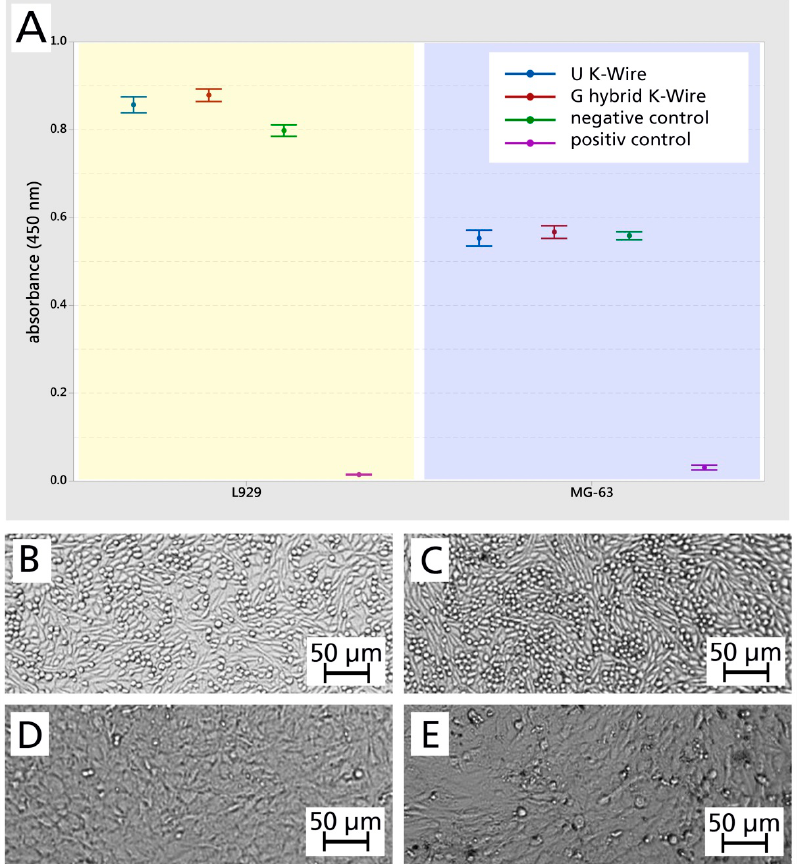
Figure 5. ( A ) Cytocompatibility testing (WST-1 assay). The results are displayed as mean values